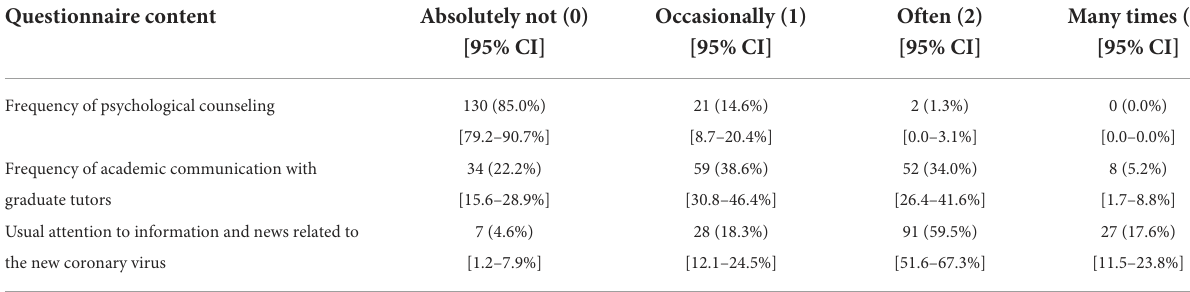
TABLE 5 The impact of the COVID-19 pandemic on mental state of medical